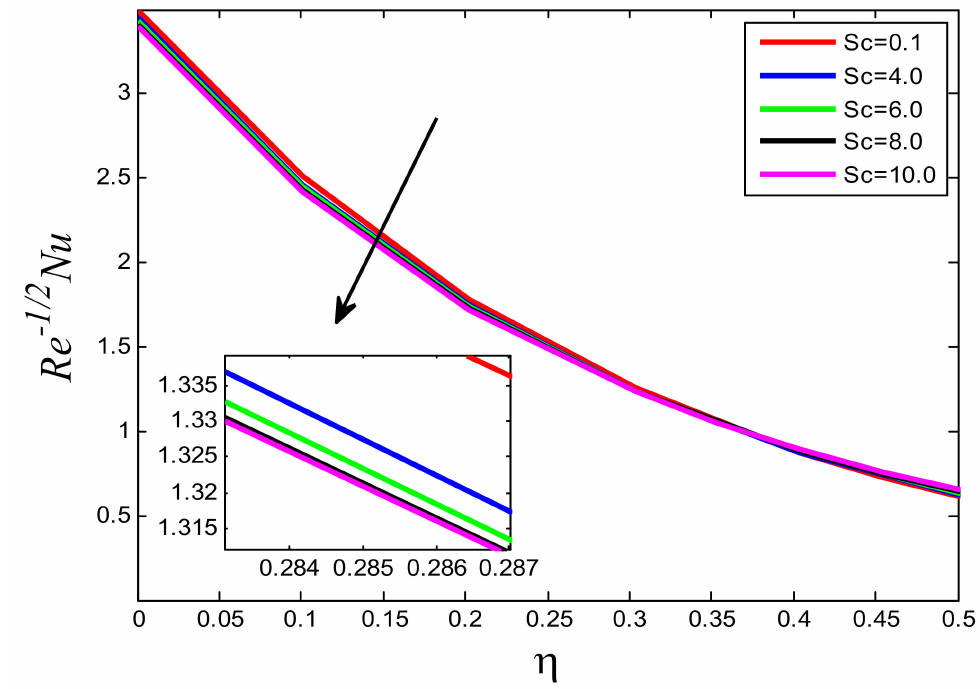
Figure 32. Influence of Sc on Re − 1/2 Nu .